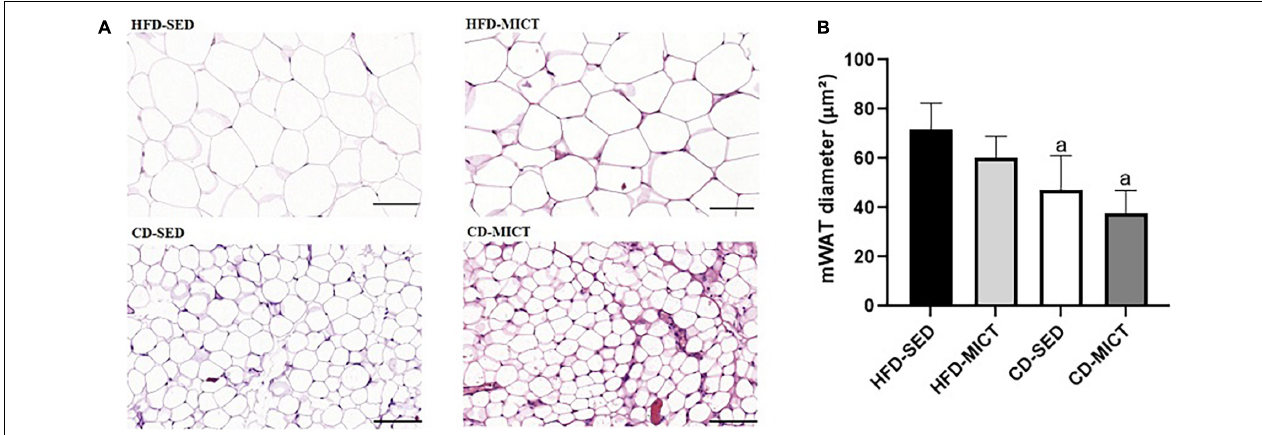
FIGURE 1 | Photomicrograph of mesenteric adipose tissue (mWAT) after 8 weeks of dietary intervention and/or MICT. (A) Representative images of mWAT tissue showing H&E staining using 20 × (100 µ m) objective. (B) Diameter of mWAT adipocytes. HFD-SED, high-fat diet sedentary ( n = 5); HFD-MICT, high-fat diet plus